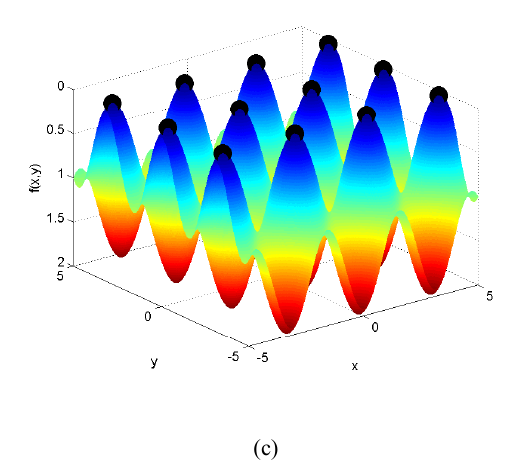
Fig. 5. Optimization results of Function 1 with CSA, SA method, and hybrid algorithm. (a) Optima obtained by CSA. (b) Optimum obtained by SA method. (c) Optima obtained by hybrid algorithm.